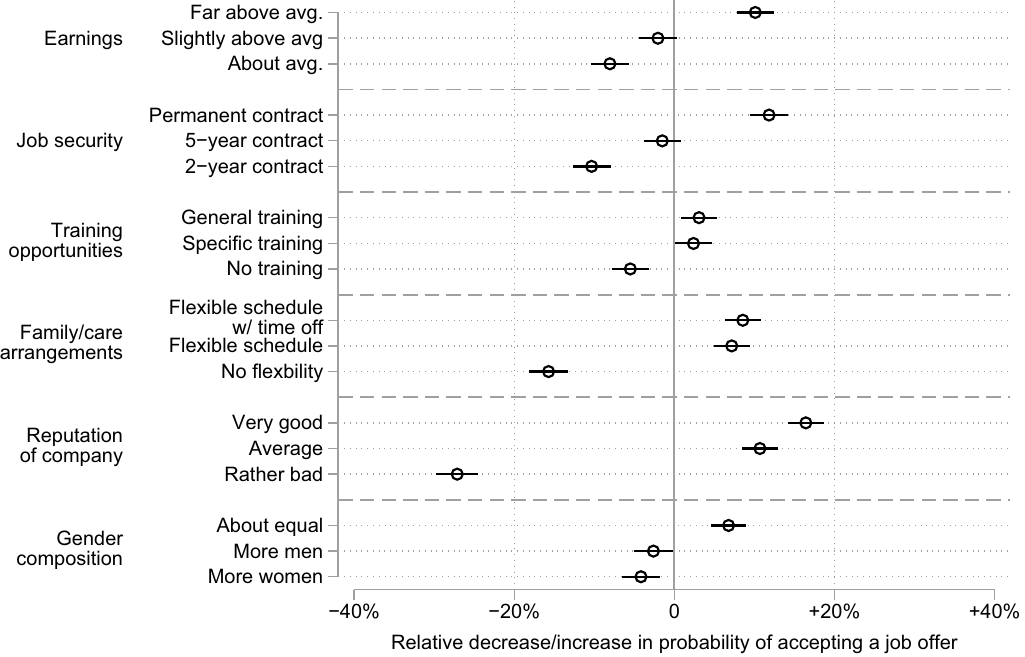
Fig 2. Preferences for job attributes among respondents in the Dutch survey. The figure shows the relative decrease/increase in probabilities (with 95% confidence intervals) of choosing a job due to the respective job attribute. and a full interaction model to formally test for gender differences (Model 1 of S4 Table). The inspection of Fig 3 suggests men and women based their decisions for or against a job offer on the same job attributes, but they had slightly different priorities. For men, the option to receive wages far above average was a stronger predictor of choosing a job than for women. While men were more likely to choose jobs with high earnings than those with slightly above average earnings ( χ 2 = 23.42; p < .001), this differentiation did not matter as much to women ( χ 2 = 1.58; p = .208). Men and women did not seem to differ considerably in their preferences for jobs with average earnings. While this resonates with our theoretical expectation that men value extrinsic aspects of a job more than women, we observed no statistically significant gen- der differences in preferences for earnings far above average ( χ 2 = 1.92; p = .166) or slightly above average ( χ 2 = 0.63; p = .428). Again, the most important aspect of a job offer for both men and women was job security, and we observed no gender differences in preferences for job security. Turning to the further training opportunities, we observed a slight leaning of women towards general human capital and of men towards specific human capital. However, these gender differences were not statistically significant. The possibility of having a flexible work schedule was significantly more important for women than for men. Women were more likely to choose job offers with flexible working hours ( χ 2 = 5.88; p = .015) and flexible job offers with time off if needed ( χ 2 = 8.48; p = .004). This is largely in line with the literature highlighting different responsibilities of men and women in the arrangements of work and family life. Lastly, the reputation of the company seemed to be somewhat more important for women. As the reputation of the company can be considered an intrinsic job characteristic, this result resonates with our theoretical expectations of the gendered valuation of extrinsic and intrinsic job attributes. Yet formal tests showed no significant gender differences ( χ 2 = 2.33; p = .127).